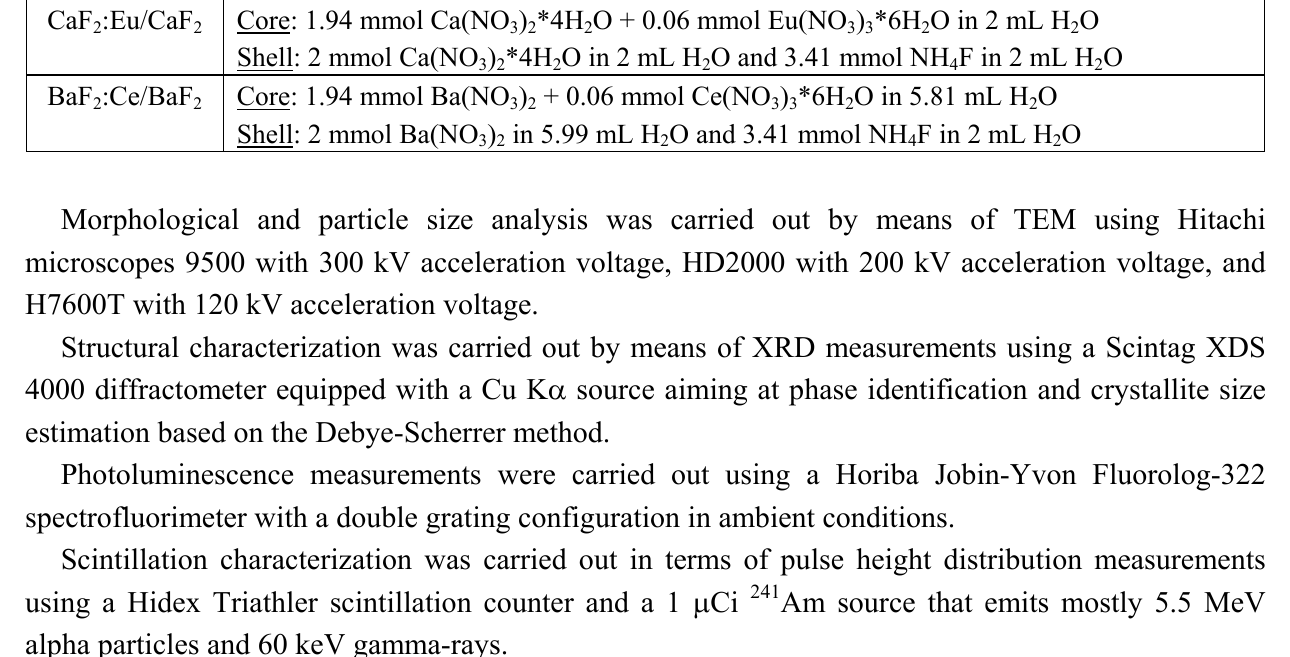
Table 1. Synthesis conditions for self-shelling and 3 mol % RE doping.